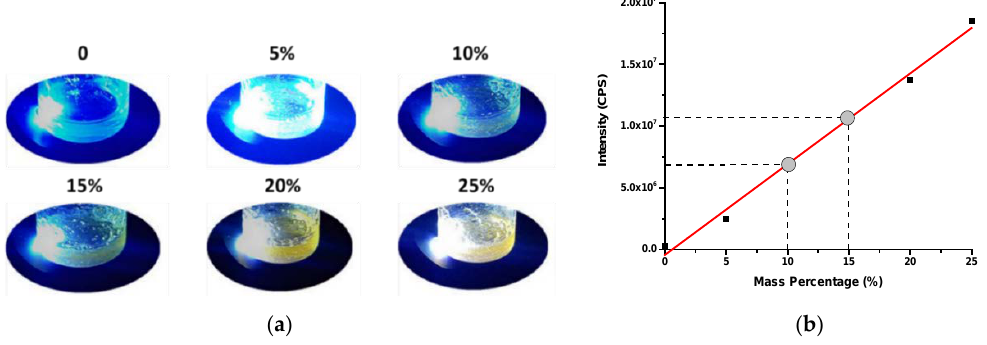
Figure 7. CDs-SPA mixed with the photopolymer resin with different mass percentage under UV lamp (365 nm) ( a ); The linear relation between the PL intensity (excitation: 425 nm; emission: 562 nm) and mass percentage of CDs-SPA in resin. R 2 = 0.99 ( b ).